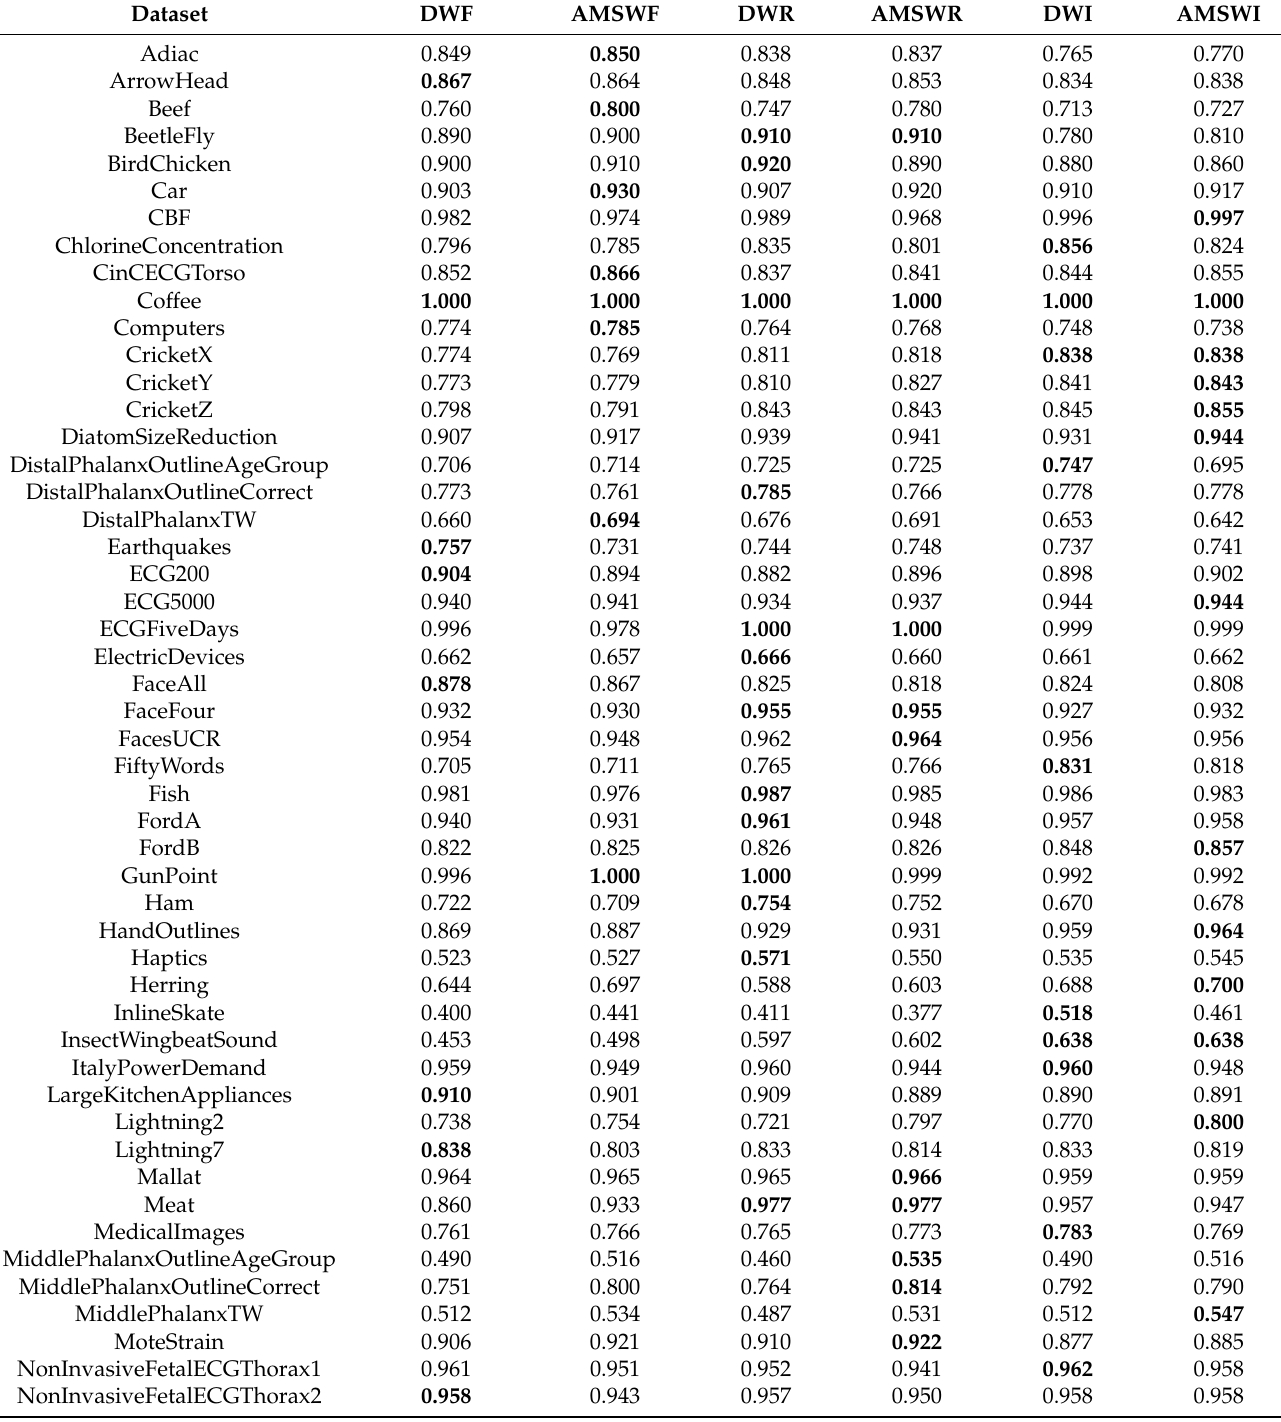
Table 2. Accuracy rates and evaluation metrics of the DW-FCN (DWF), DW-ResNet (DWR), DW-Inception (DWI), AMSW- this Table for each dataset is the average of five evaluations on the testing set. For each evaluation, the model corresponding to the minimum training loss is used to predict the label and calculate the accuracy on the testing set. The accuracy rates keep three decimal places for clariy. The highest value (bold) in each dataset is actually based on the original